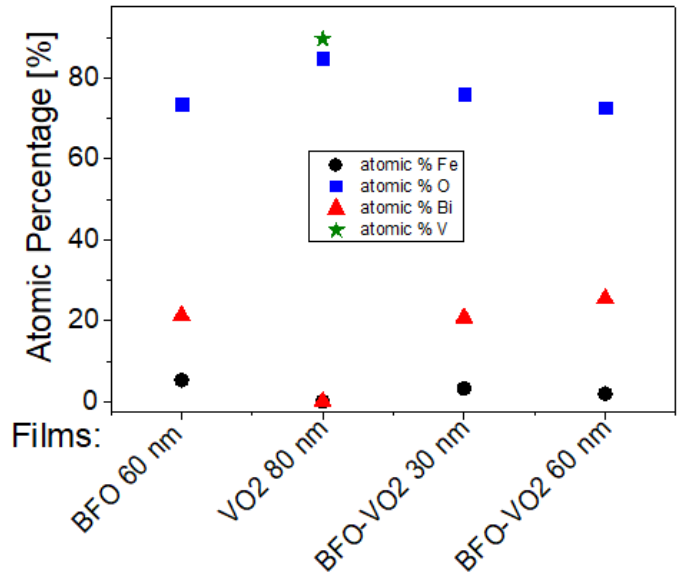
Table 1. Summary of atomic percentages on the surface of the thin films obtained.